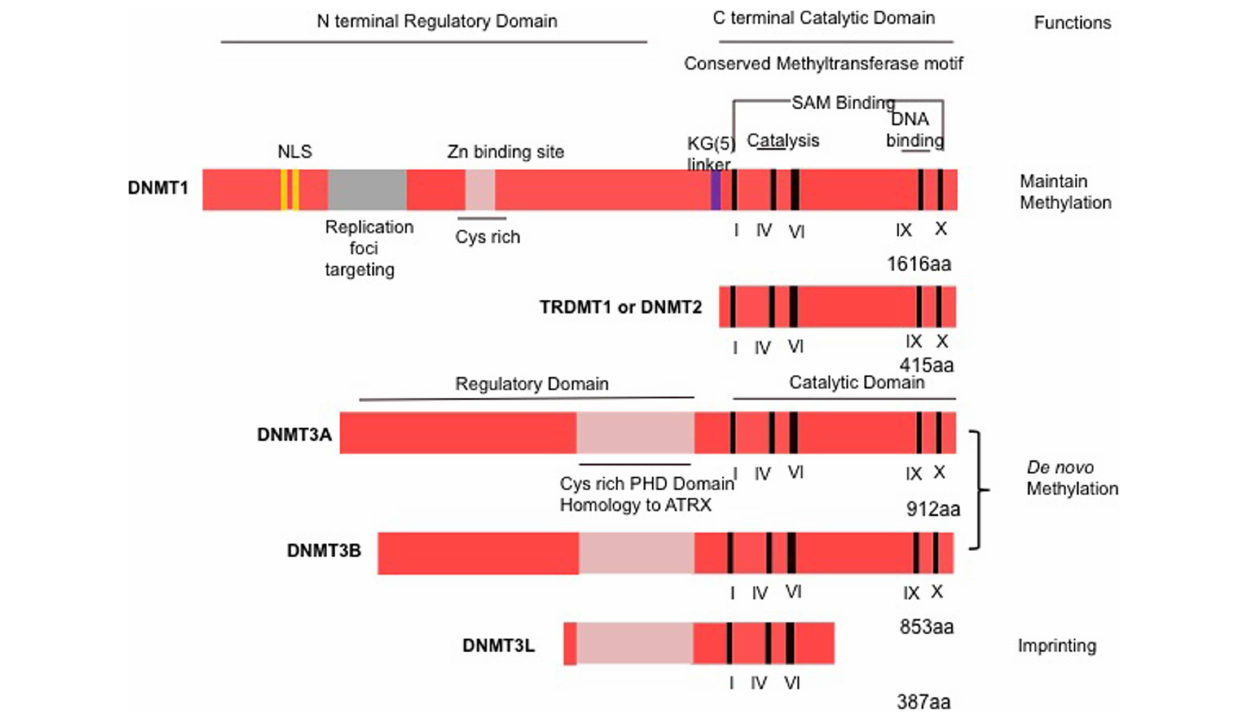
Frontiers in Oncology | Cancer MolecularTargets